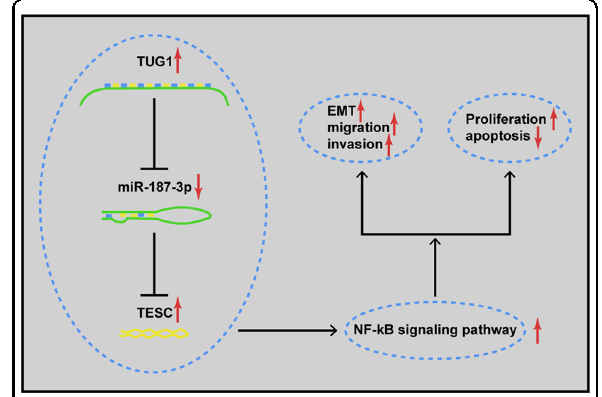
Fig. 8 Schematic representation of a model for the major molecular mechanisms of lncRNA TUG1/miR-187-3p/ TESC axis in pituitary adenoma, which indicates that TUG1 sponges miR-187-3p to affect PA development by elevating TESC and regulating the NF- κ B signaling